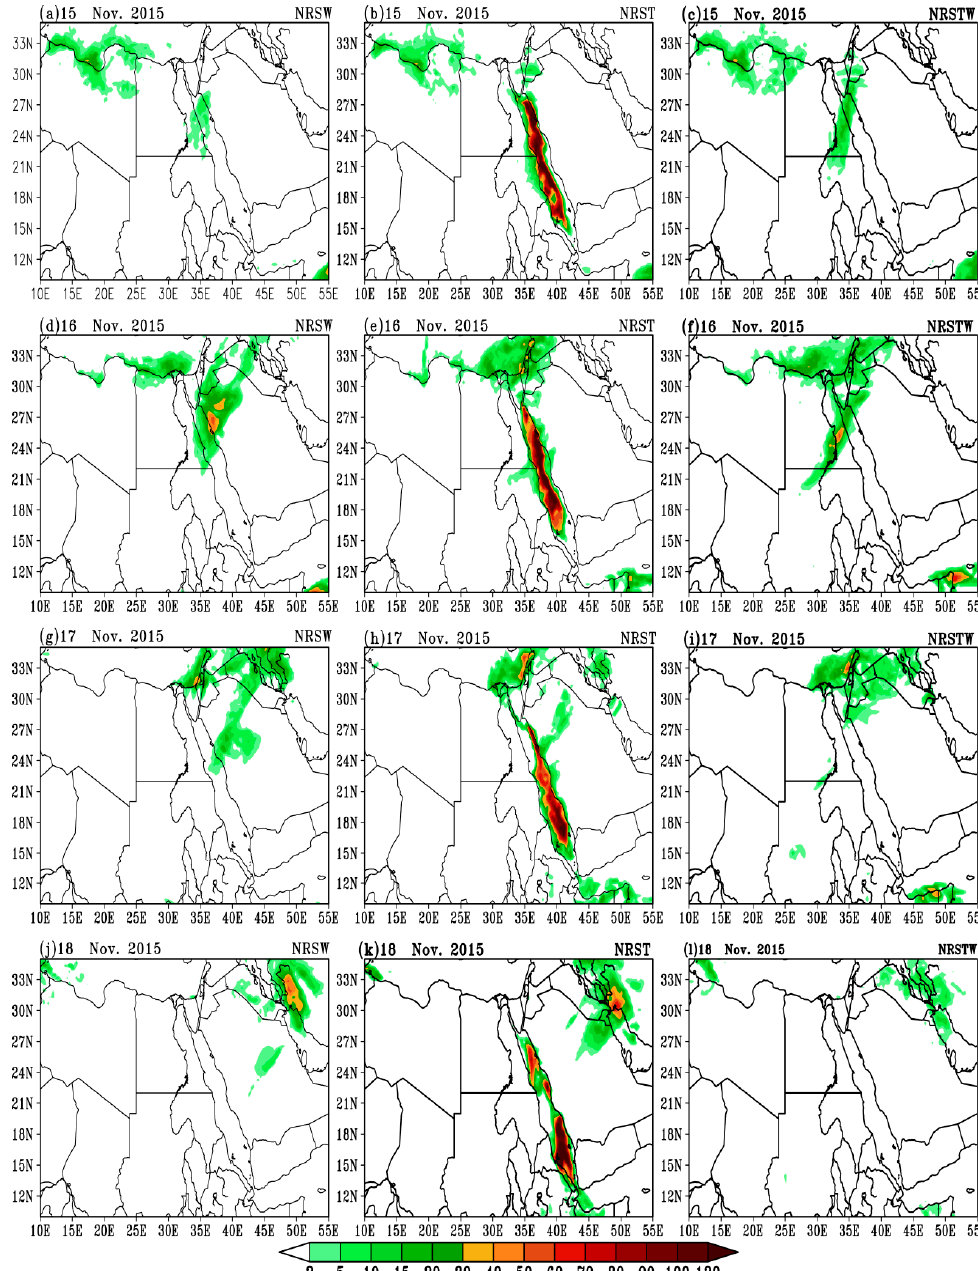
Figure 9. The accumulated daily rainfall from NRSW ( a , d , g , j ), NRST ( b , e , h , k ), and NRSTW ( c , f , i , l ) for the period of 15–18 November 2015.